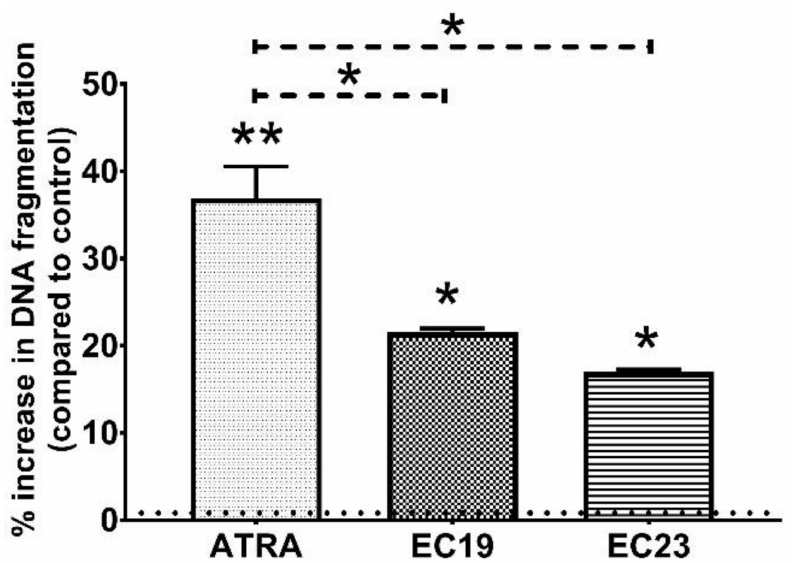
Figure 3. Retinoid-induced DNA fragmentation in Caco-2 cells after 24 h. The cells were treated with the IC 50 concentrations of ATRA, EC19 or EC23. The DNA fragmentation after treatment was quantified colorimetrically as the relative percentage of fragmented DNA to the total DNA content in each sample compared to 0.1% DMSO control (dotted line) and depicted as the mean percent increase in DNA fragmentation ± SEM of three independent experiments ( n = 3). All retinoids induced significant DNA fragmentation in comparison to ATRA highlighting their genotoxicity in Caco-2 cells. * p < 0.05 and ** p < 0.01 indicate statistically significant